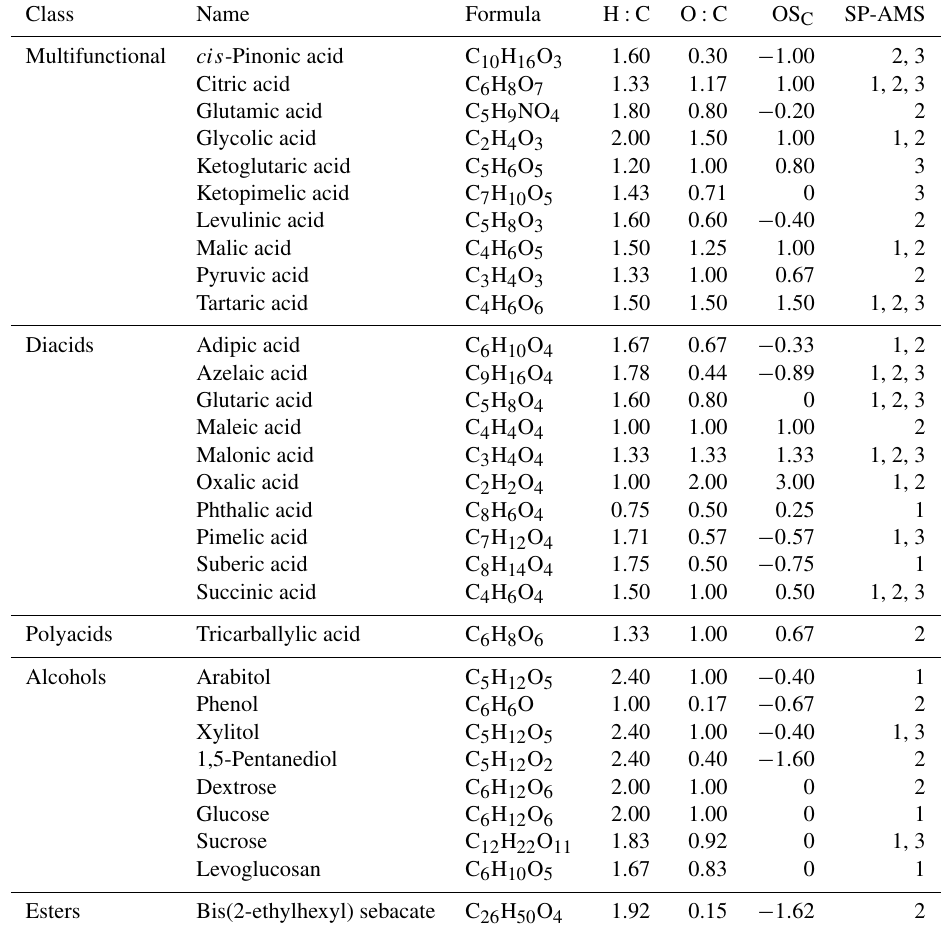
Table 1. Summary of the true values of H : C, O : C, and OS C of the oxygenated organic species tested by the three SP-AMSs. Class